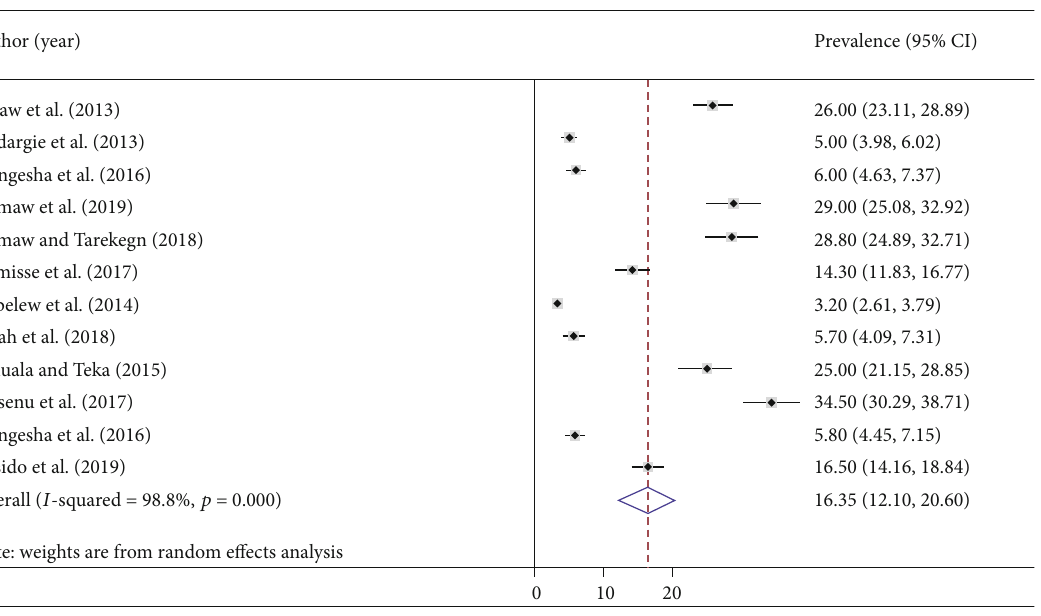
Figure 2: Forest plot of the pooled prevalence of neonatal